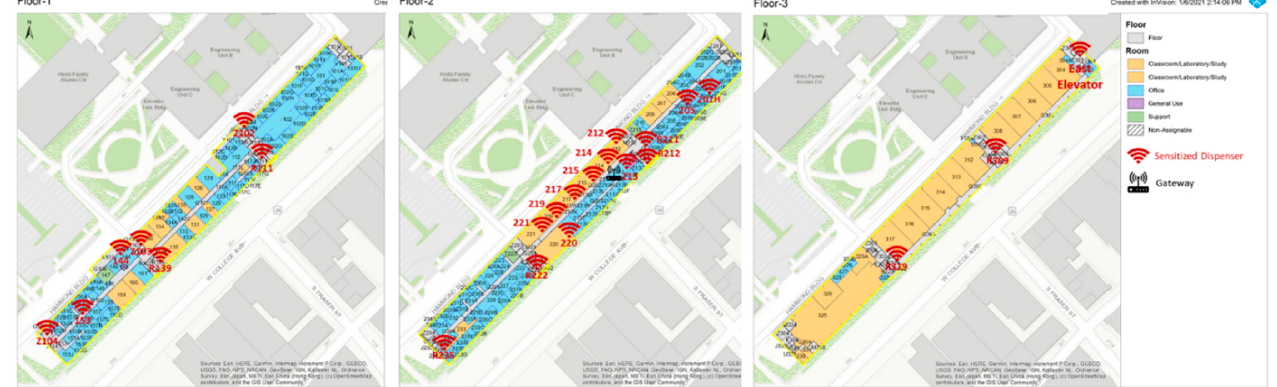
Table 2. Sensor module deployment.